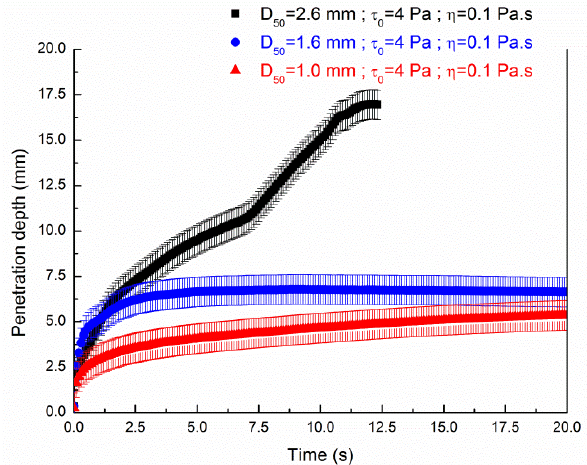
Figure 10. Influence of the average diameter of the sand bed particles on the penetration depth of a cement paste ( 𝜏 0,𝑒𝑥𝑝 = 4 Pa; 𝜂 𝑒𝑥𝑝 = 0.1 Pa · s) of 20 mm height as a function of time.